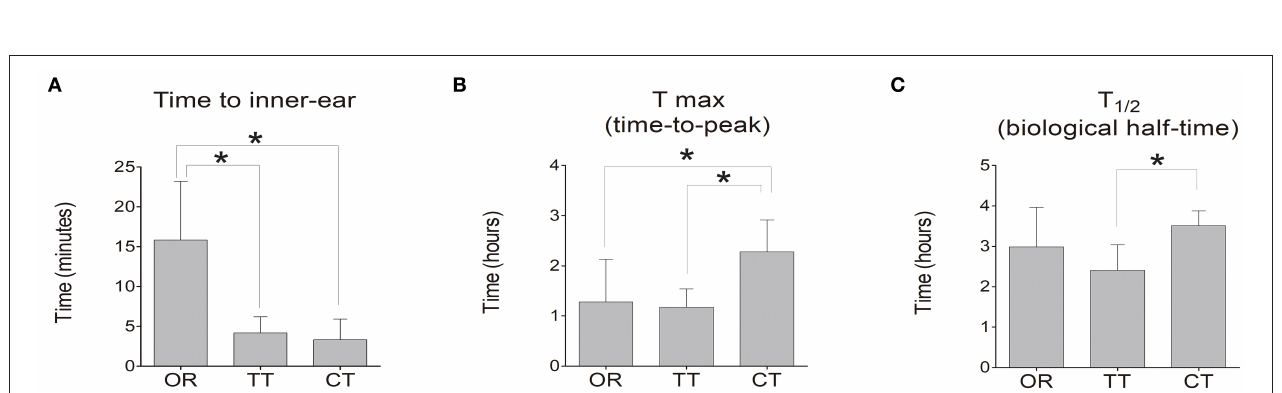
FIGURE 3 | Time to inner-ear, time-to-peak of photon count (T max ), and biological half-life (T 1 / 2 ) of D-luciferin in the inner ear. (A) Time at which photon count appeared in the inner ear in each group; (B) T max of D-luciferin was detected in each group. (C) T 1 / 2 . Data represent means ± SE. The bar graph shows the average value of the mice in each group, and the error bar indicates the standard deviation. * P < 0.05.